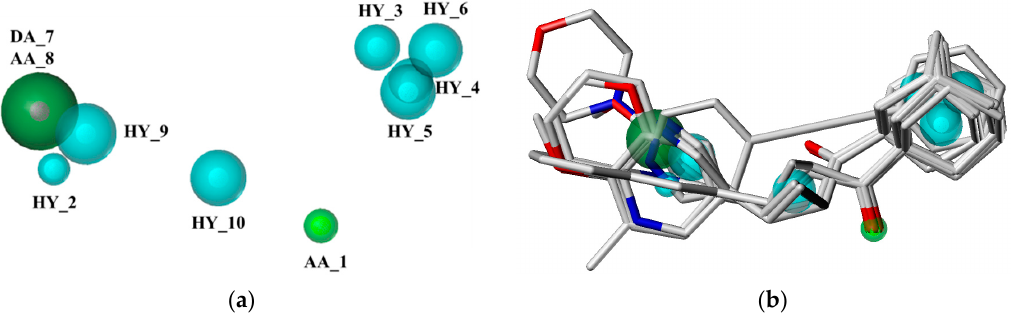
Figure 3. ( a ) The optimal pharmacophore model of allosteric site of mGluR I (model 01); ( b ) Model 01 mapped with the compound used to build model. Table 2. The ranking results of orthosteric GALAHAD models of mGluR I.